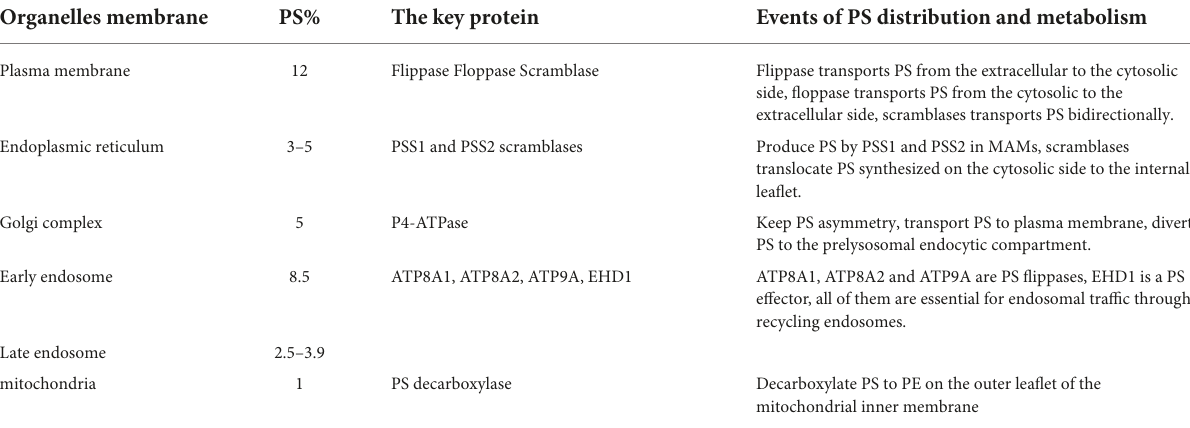
TABLE 1 The biological events of phosphatidylserine (PS) and the percentage of PS in total phospholipid of different organelles. Organelles membrane PS% The key protein Events of PS distribution and metabolism Plasma membrane 12 Flippase Floppase Scramblase Flippase transports PS from the extracellular to the cytosolic side, floppase transports PS from the cytosolic to the extracellular side, scramblases transports PS bidirectionally. 3–5 PSS1 and PSS2